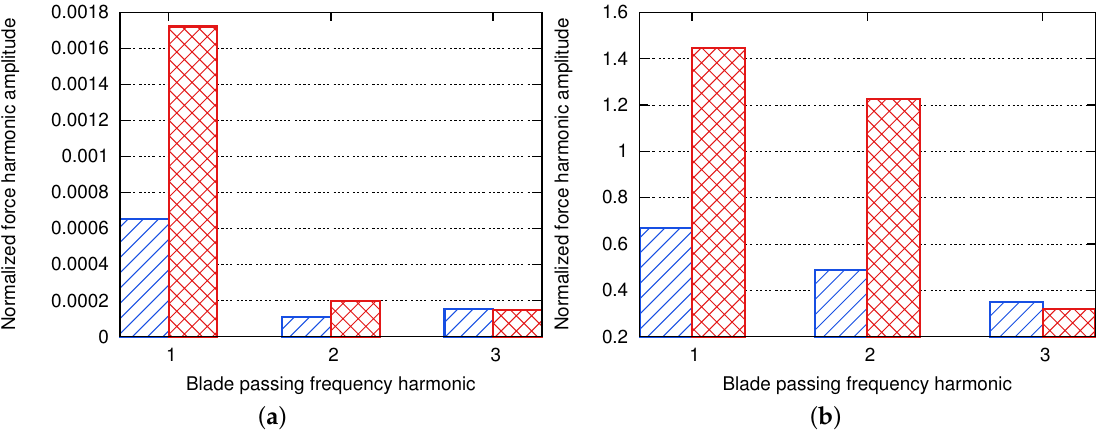
Figure 15. Normalized mean value ( a ) and standard deviation ( b ) of the integrated OGV loading at the BPF and its harmonics: axisymmetric air inlet in hatched blue bars and asymmetric air inlet in crosshatched red bars.